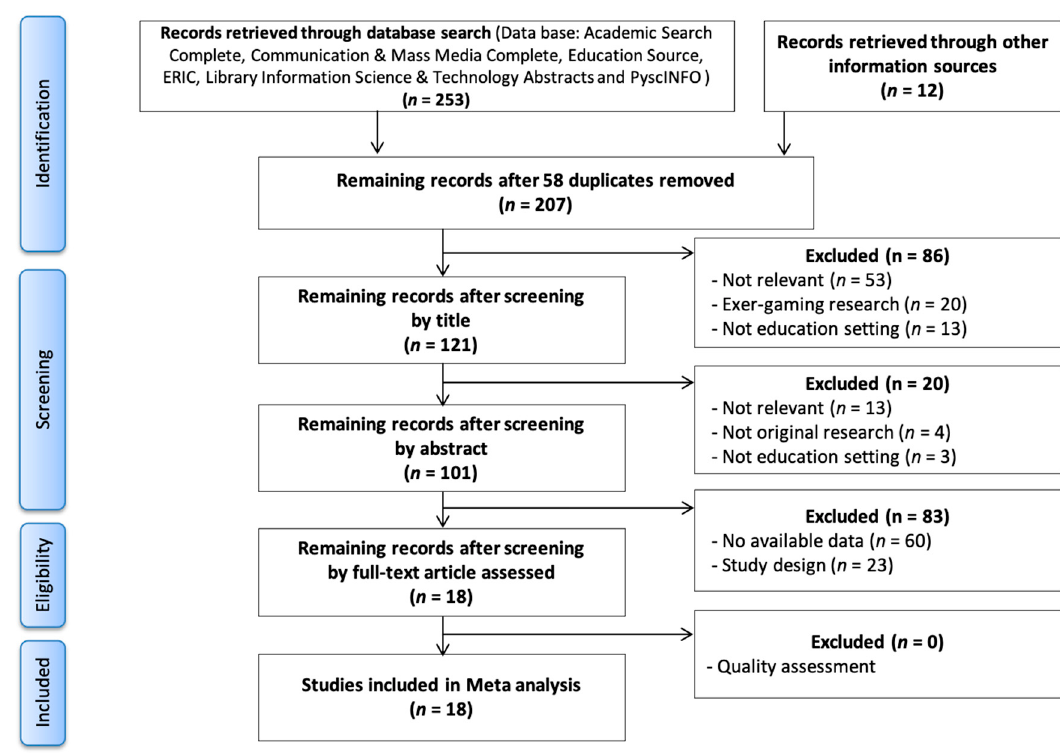
Figure 1. Preferred Reporting Items for Systematic Reviews and Meta-Analyses (PRISMA) flow chart.